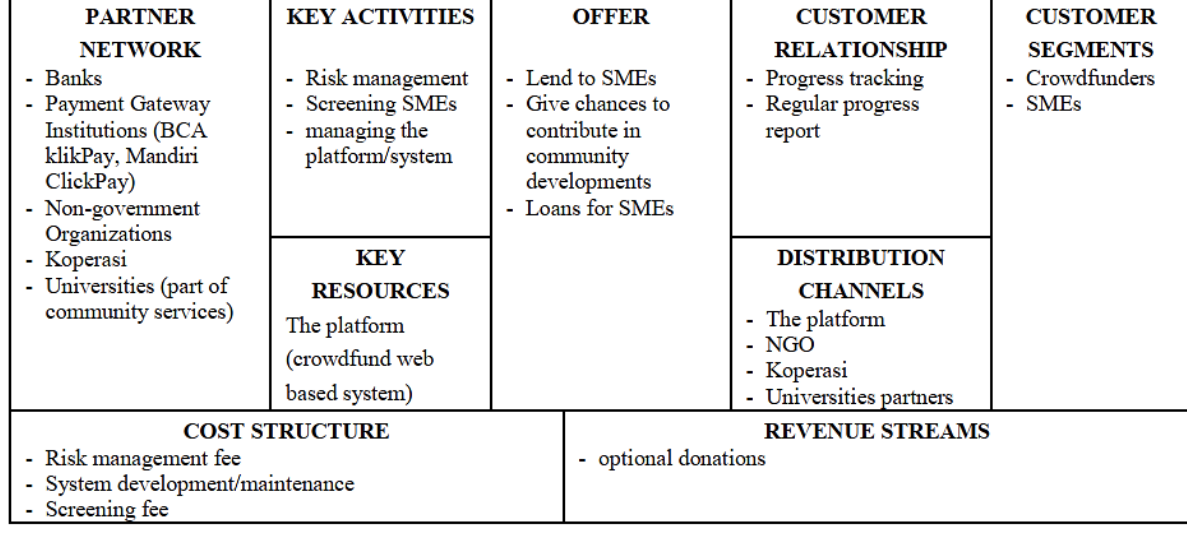
Figure 2. Business Model Canvas [21]